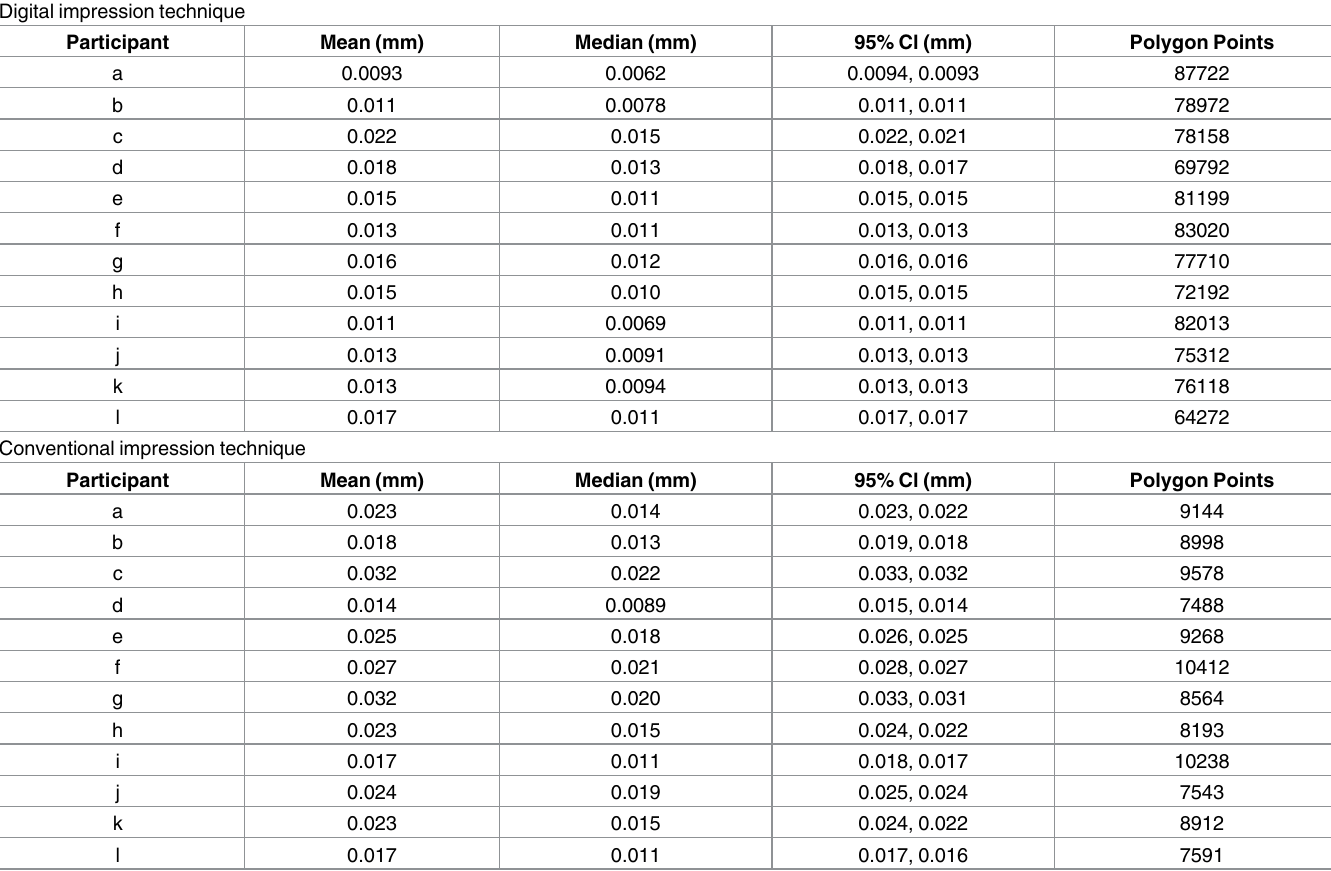
Table 1. The number of polygon points analyzed and the averageabsolute value discrepancy of all measurement points for each participant. Digital impression